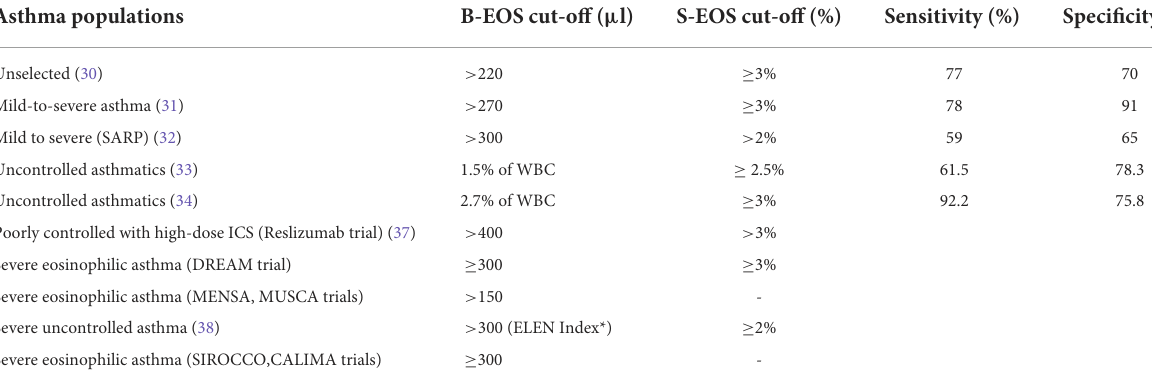
TABLE 1 Blood eosinophils cut-off as predictor of airways eosinophilia. Asthma